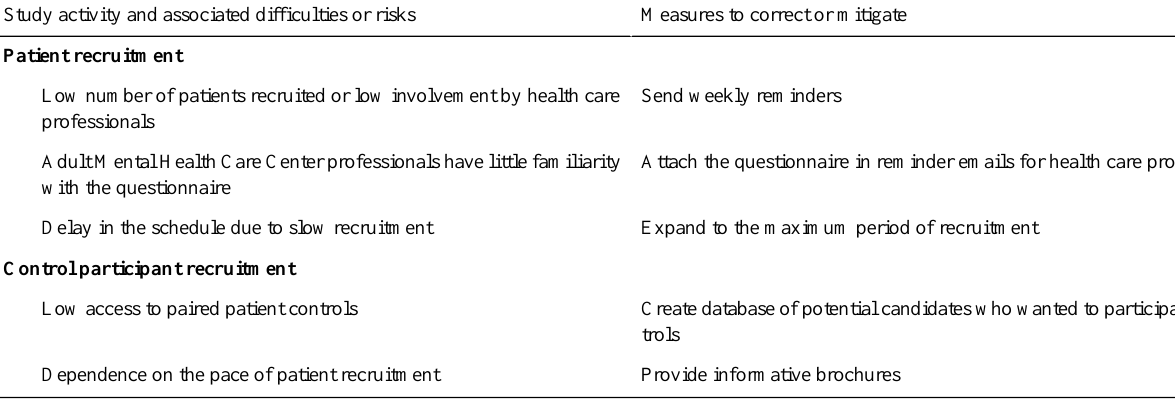
Table 2. Difficulties associated with participant recruitment and their correction measures.